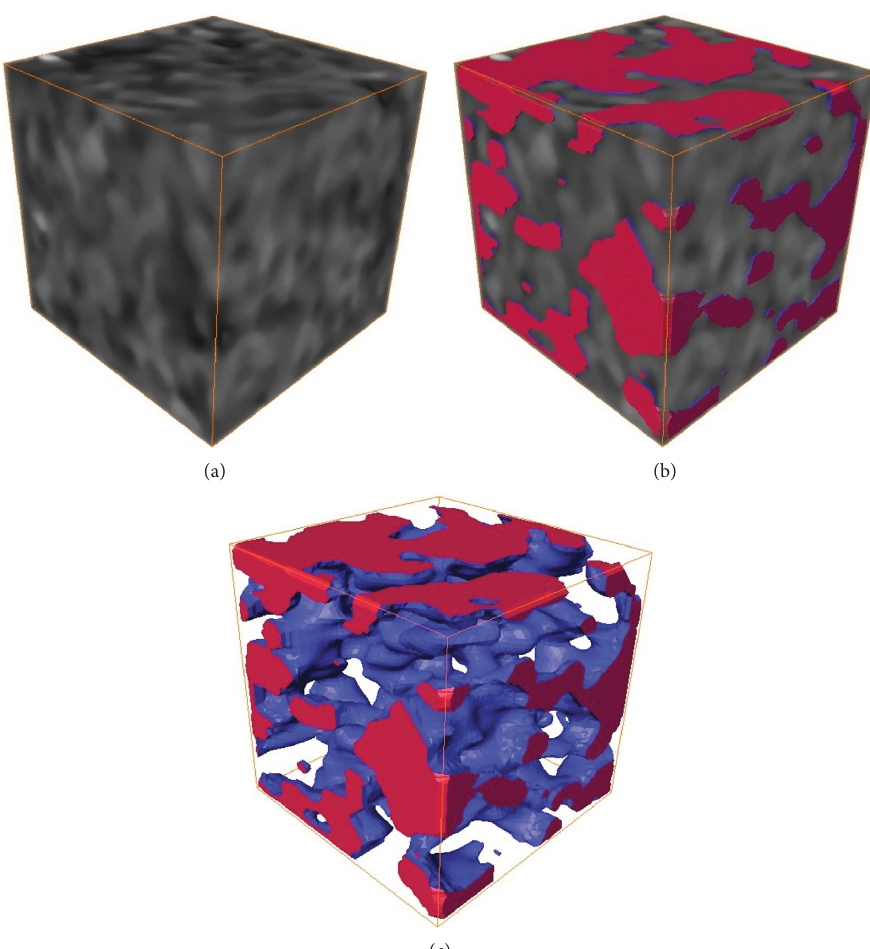
Figure 9: Model of coal’s micropore structure in model P